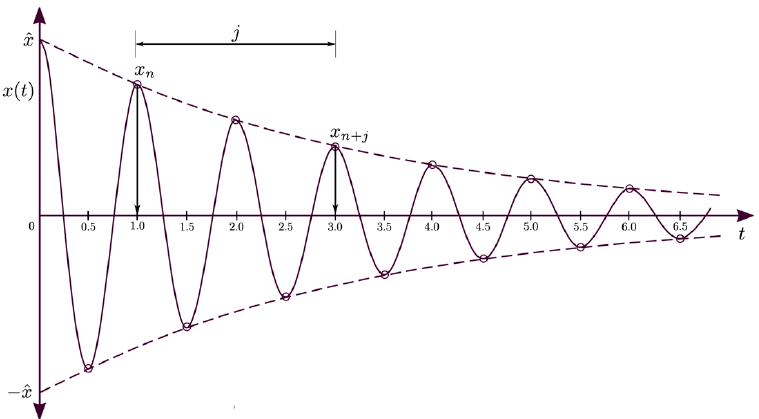
Figure 2. Typical decaying response, where ˆ x is the maximum amplitude, and x n and x n + j are successive peak amplitudes.